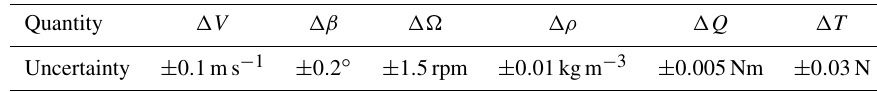
Table 1. A priori uncertainty estimates of